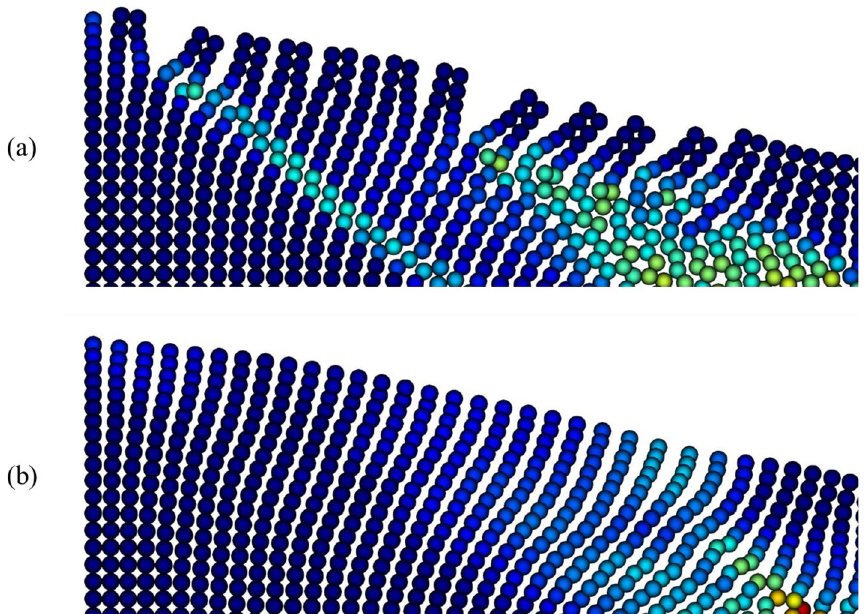
Fig. 22 Close‑up of the top of the levee at t = 1.5 s for the pure SL‑RK simulation ( a ) and coupled L–SL RK ( b ); numerical fracture occurs in the pure SL‑RK case due to insufficient kernel support coverage of